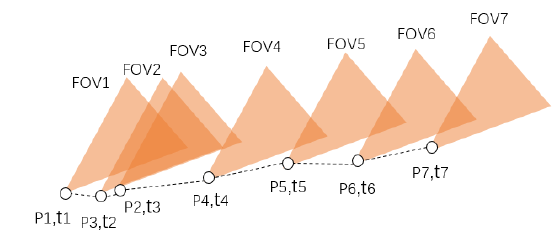
Figure 5. An example of spatial and temporal